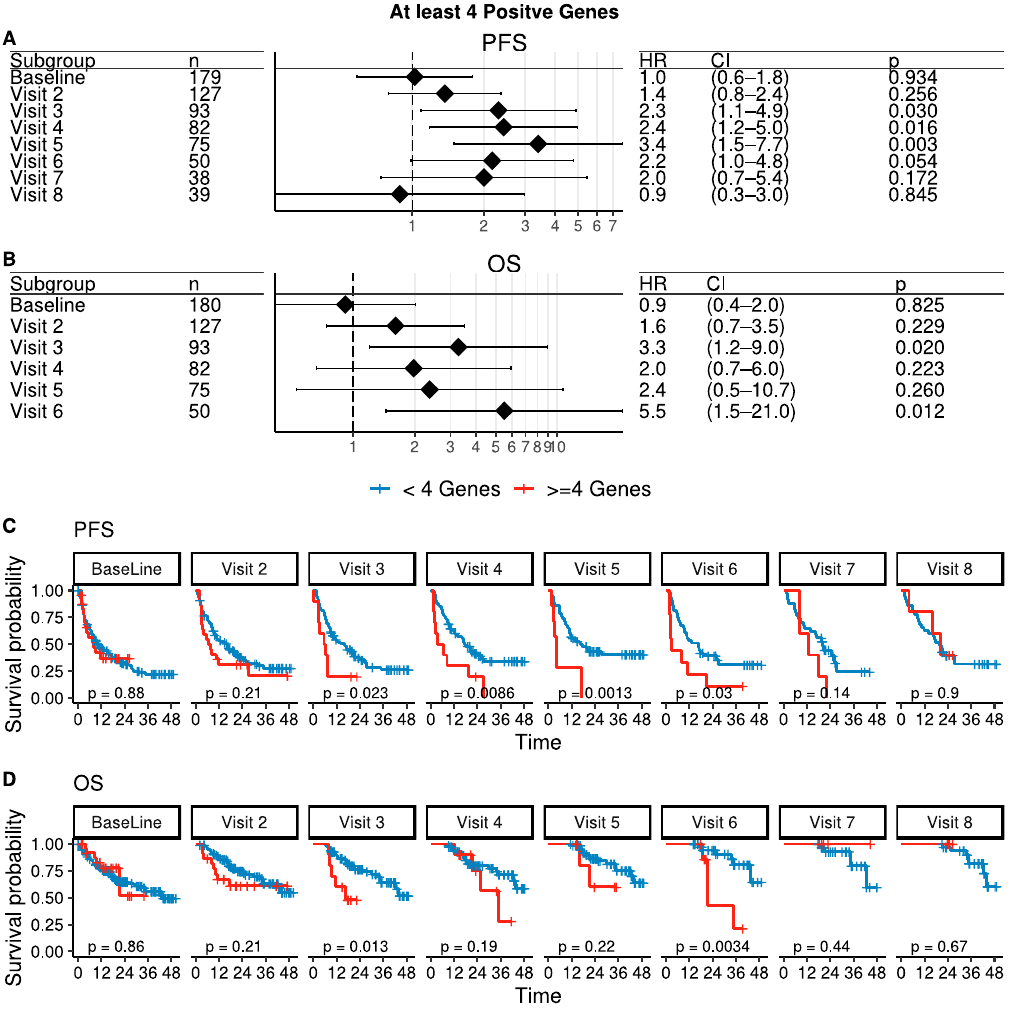
Figure 4. Expression of at least 4 CTC-related genes is prognostic for evaluation of response to therapy. ( A , B ) Forest plots showing Cox proportional hazard for PFS and OS stratified by ≥ 4 CTC-related genes at each timepoint. ( C , D ) Kaplan-Meier plots for PFS and OS stratified by ≥ 4 CTC-related genes. CTC, circulating tumor cell; PFS, progression-free survival; OS, overall survival.